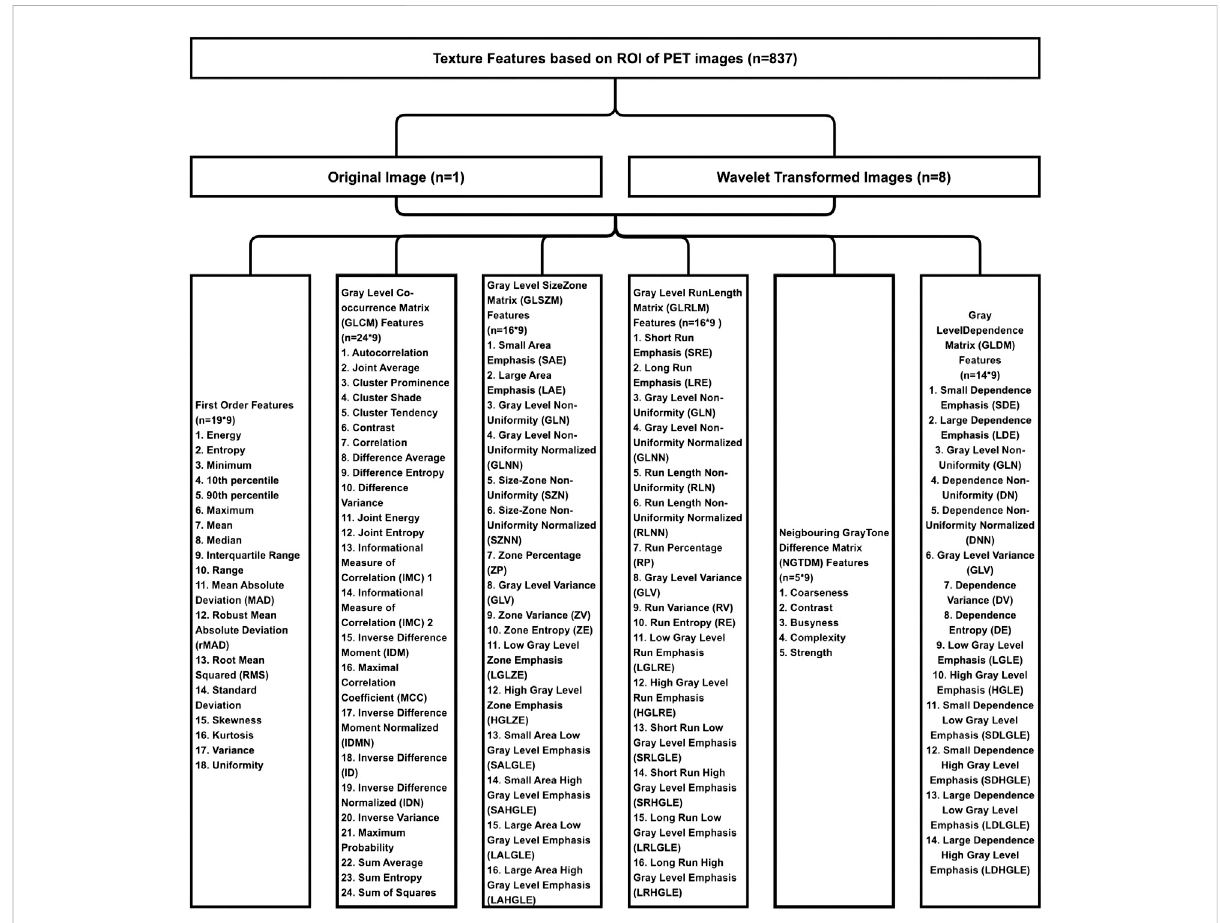
FIGURE 2 Theresult ofextracting texture featureparametersofPETimages.Eighthundred andthirty-seventexturefeatureswereextracted fromtheROI in the PET image, including the fi rst order features ( n = 18), gray level co-occurrence matrix (GLCM) features ( n = 24), gray level size zone matrix (GLSZM) features ( n = 16), gray level run length matrix (GLRLM) features ( n = 16), neigbouring gray tone difference matrix (NGTDM) features ( n = 5), gray level dependence matrix (GLDM) features ( n = 14), and wavelet features derived from one level of wavelet decomposistions yielding eight derived images ( n =